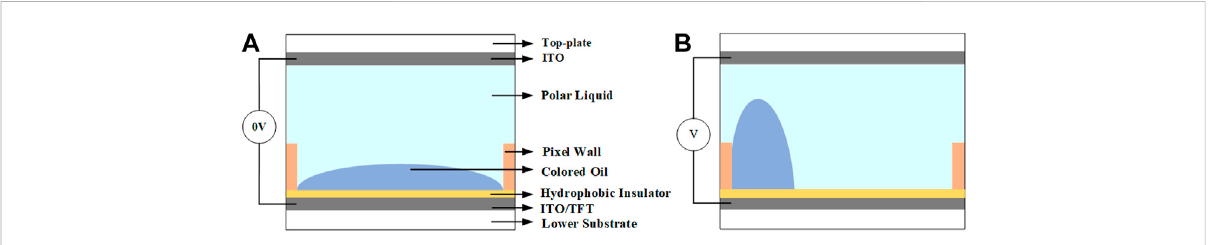
FIGURE 1 SideviewofanEWDpixelstructure,thepixelisequivalenttoan “ off ” state. (A) Pixelisequivalenttoan “ off ” state. (B) Pixelisequivalenttoan “ on ”